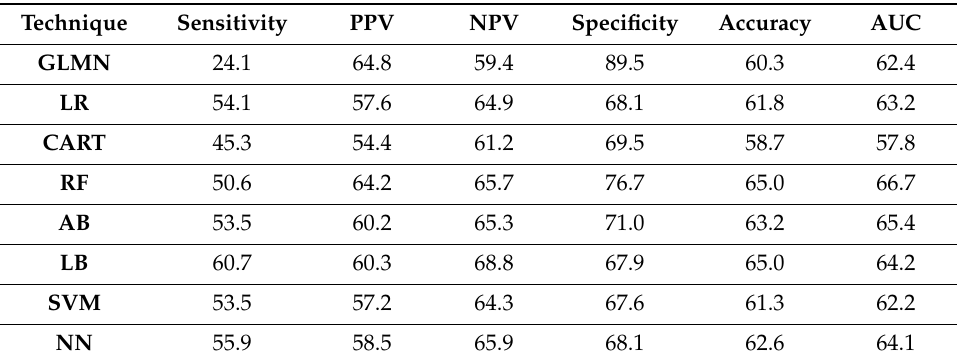
Table 4. Performance of GLMN, LR, CART, RF, AB, LB, SVM, and NN obtained with KNN-I analysis. The values represent sensitivity, positive predictive value (PPV), negative predictive value (NPV), specificity and accuracy averaged over the values obtained on each resample.